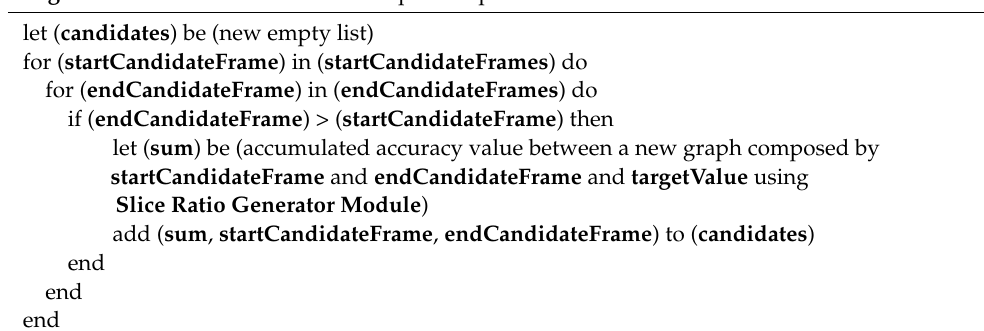
Algorithm 3: Pseudo code for the Graph Comparer module of the